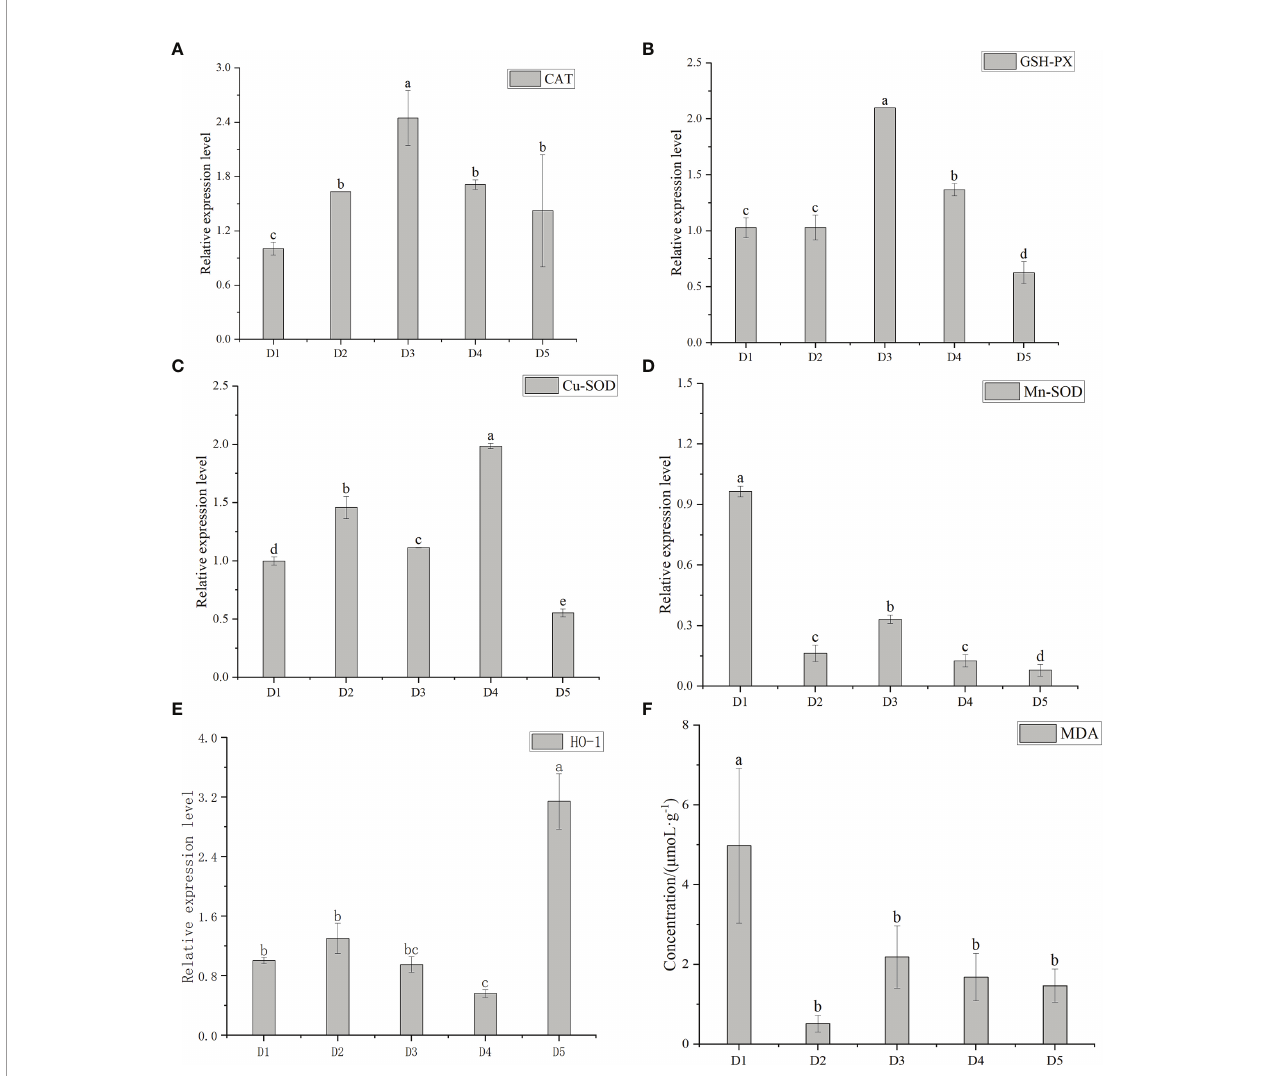
FIGURE 4 | The relative expression of catalase (CAT) (A) , glutathione peroxidase (GSH-PX) (B) , Cu-Superoxide Dismutase (Cu-SOD) (C) , Mn-Superoxide Dismutase (Mn-SOD) (D) and heme oxygenase- 1 (HO- 1) (E) and concentration of malondialdehyde (MDA) (F) of greater amberjack after transportation under different durations. Different letters above bars indicate signi fi cant differences at the 0.05